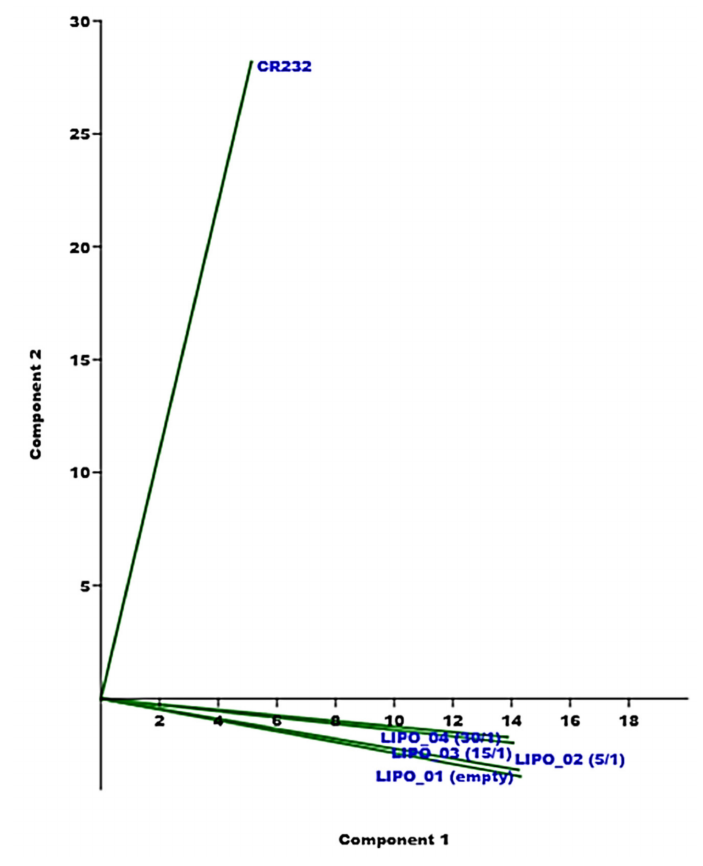
Figure 9. Results of PCA (represented as a score plot) performed on the matrix collecting the spectral data of CR232, SUVs (LIPO_01, empty liposomes), and CR232-SUVs, as well as the lipids/CR232 ratios of 5/1 (LIPO_02), 15/1 (LIPO_03), and 30/1 (LIPO_04) (PC1 vs. PC2). Accordingly, CR232-G5K NPs were located with a low positive score on PC1 and a high positive score on PC2. Importantly, CR232-G5K NPs were positioned closer to CR232 (score around 0 on PC1 and close to 10 on PC2) than to G5K, which had a high positive score on PC1 and a negative score on PC2, thus evidencing that the chemical